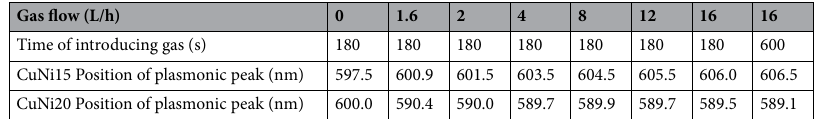
Table 5. Position of plasmonic peak according to gas flow and time of